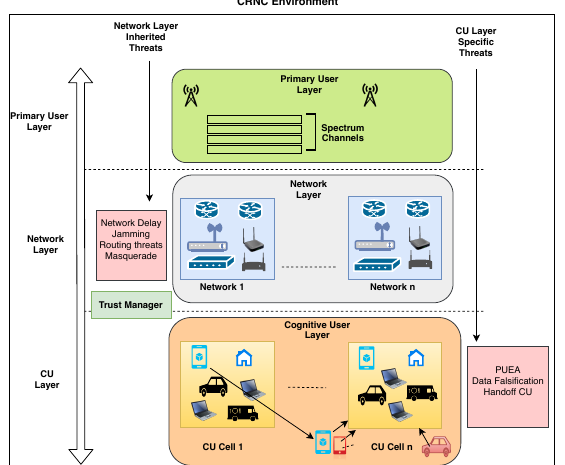
Figure 2. The Cognitive Radio Network Cell (CRNC) milieu together with specified and inherited security attacks. PUEA, Primary User Emulation